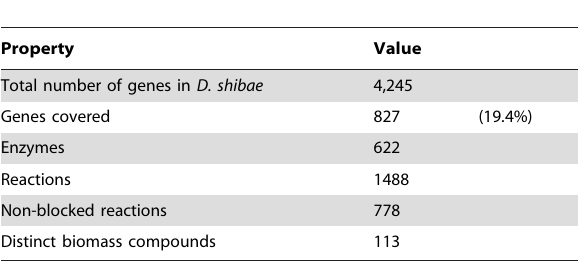
Table 2. Properties of the genome-scale metabolic model i